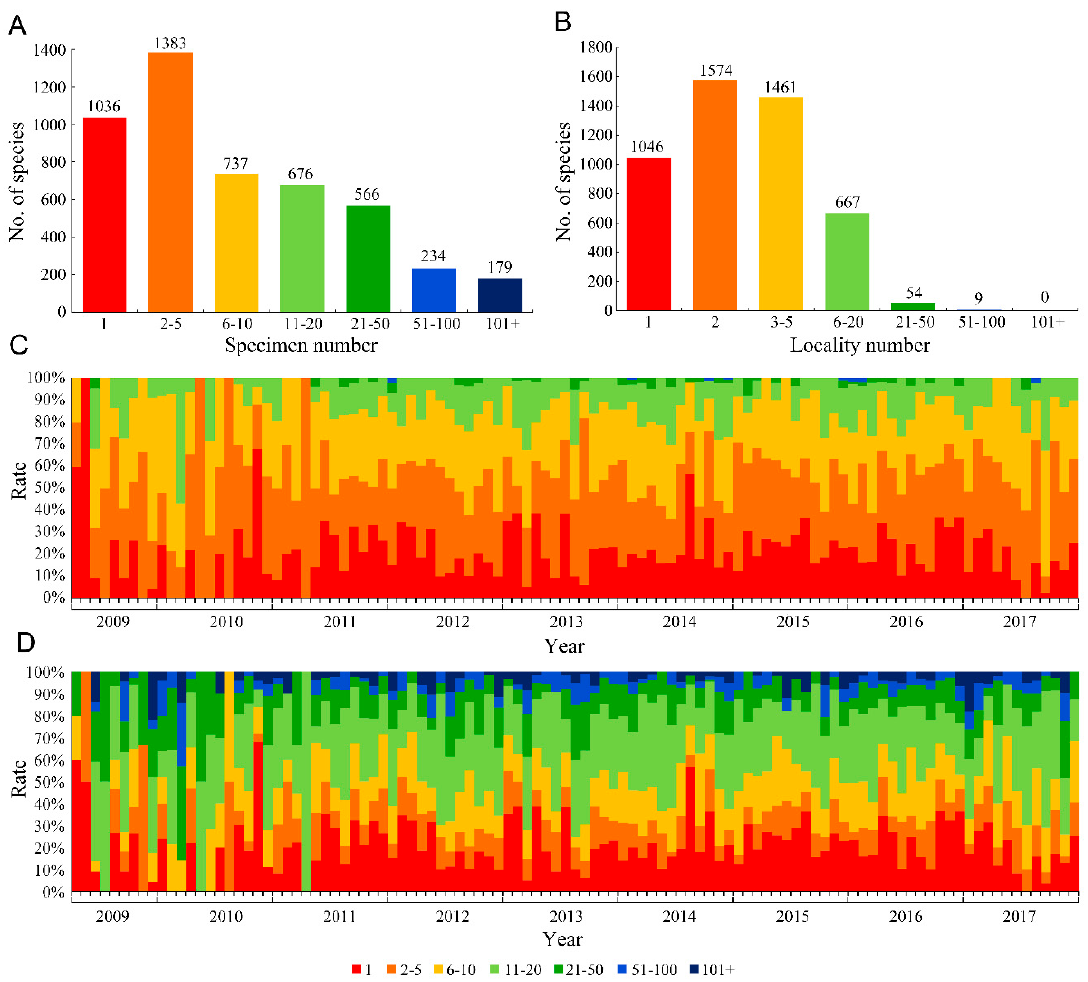
Figure 1. The distribution of numbers of type specimens and localities used in the descriptions of new insect species during 2009 to 2017. ( A ) Type of specimens, usage, and number of species. ( B ) Locality coverage of the type of specimens and number of species. ( C ) Temporal trend of the number of type of specimens used. ( D ) Temporal trend of number of localities of the type of specimens.